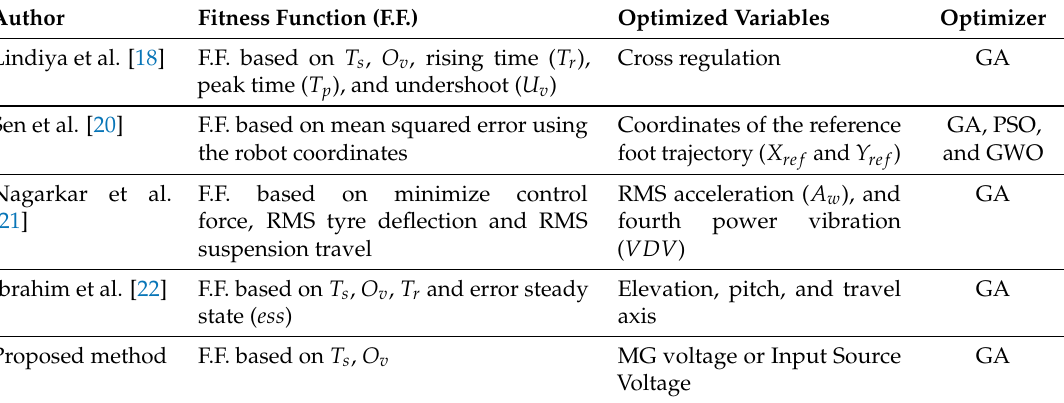
Table 10. Functional comparison of hybrid PI-LQR